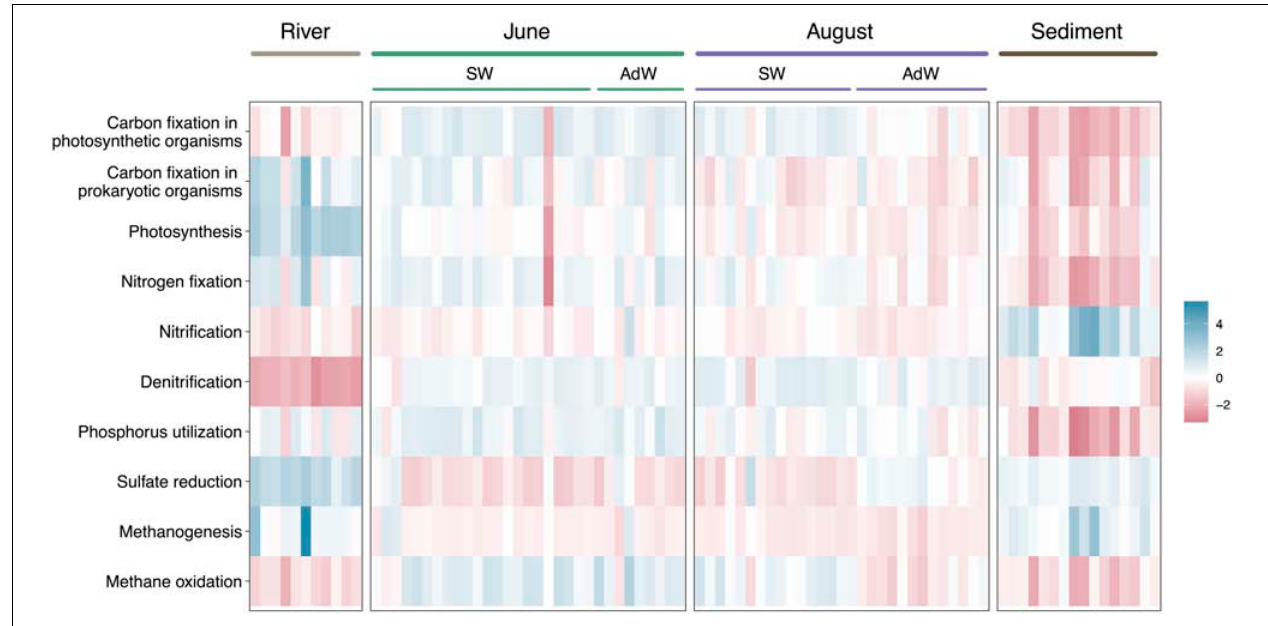
FIGURE 5 | Heatmap showing differential abundances of the principal predicted functions in element cycling. Functions were predicted based on taxonomy using Tax4Fun (R). Relative abundances were z scaled to be comparable (differential abundance). For water column samples, the sampling month is indicated above the plot, and samples are further separated between surface waters (SW) and advected waters (AdW). Blue indicates a high abundance, and red a low abundance. Metabolic functions were determined with KEGG Orthologs genes or enzymes related to the KEGG reaction or pathway ( Supplementary Table 2